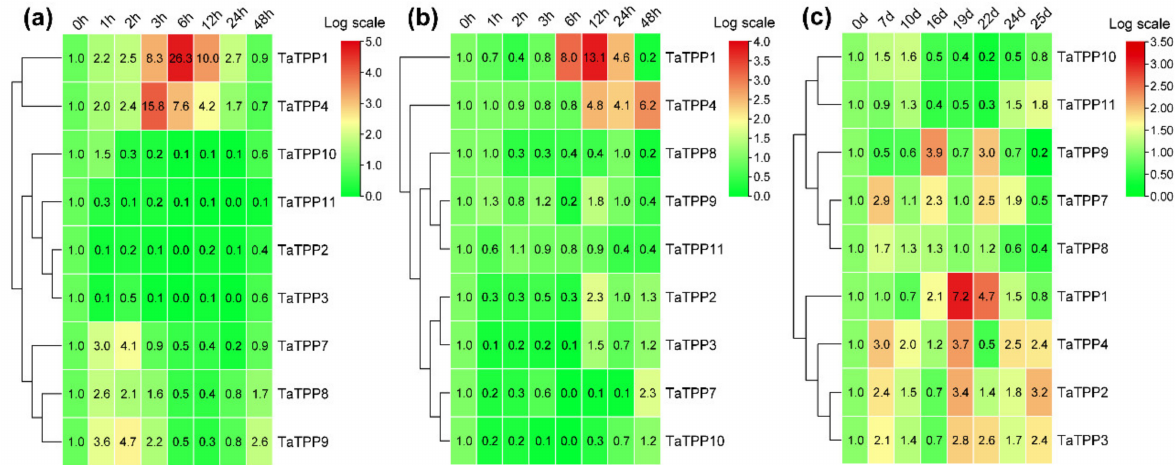
Figure 9. Relative transcript profiles of TaTPPs in response to ( a ) abscisic acid (ABA), ( b ) drought stress and ( c ) leaf senescence. The relative transcripts of all genes were analyzed using qRT-PCR. The relative transcript levels of TaTPPs were measured using the comparative threshold (2 − ∆∆ CT ) method. Data normalized with the transcripts of wheat elongation factor, TaEF-1 α . The 0 h post treatment ( a,b ) or 0 days after anthesis ( c ) was used as a control and standardized with 1. Red and green colors denote strong and weak transcription of TaTPPs , respectively. The heat map was generated with TBtools and tree was constructed with the average linkage clustering method.